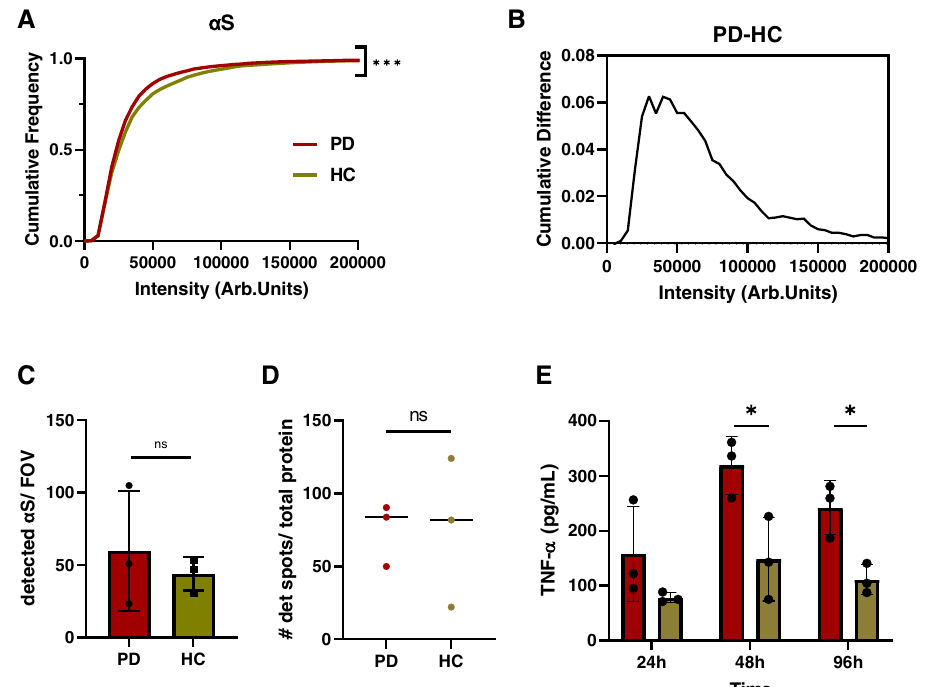
Fig. 8 | Smaller aggregates in PD brains comprise α -synuclein and PD-derived aggregates induce a greater in fl ammatory response. A Cumulative frequency distribution for α -synuclein aggregate intensity for PD (burgundy, N =6866) and control (beige, N =3157) measured using SiMPull with the epitope-speci fi c SC antibody. Each histogram is the collected data from three cases. (Kolmogorov- Smirnoff, p <0.001 for PD vs controls). B Cumulative difference for α -synuclein intensity for PD and controls, measured using SiMPull. C Number of detected α - synuclein aggregates per fi eld of view for PD ( N =3)and controls( N =3). Error bars aremean±STD fromthree cases.(two-tailed unpaired t -test, p =0.559, N =3).Each pointrepresentsoneofthethreepatientspergroup. D Scatterplotforthenumber